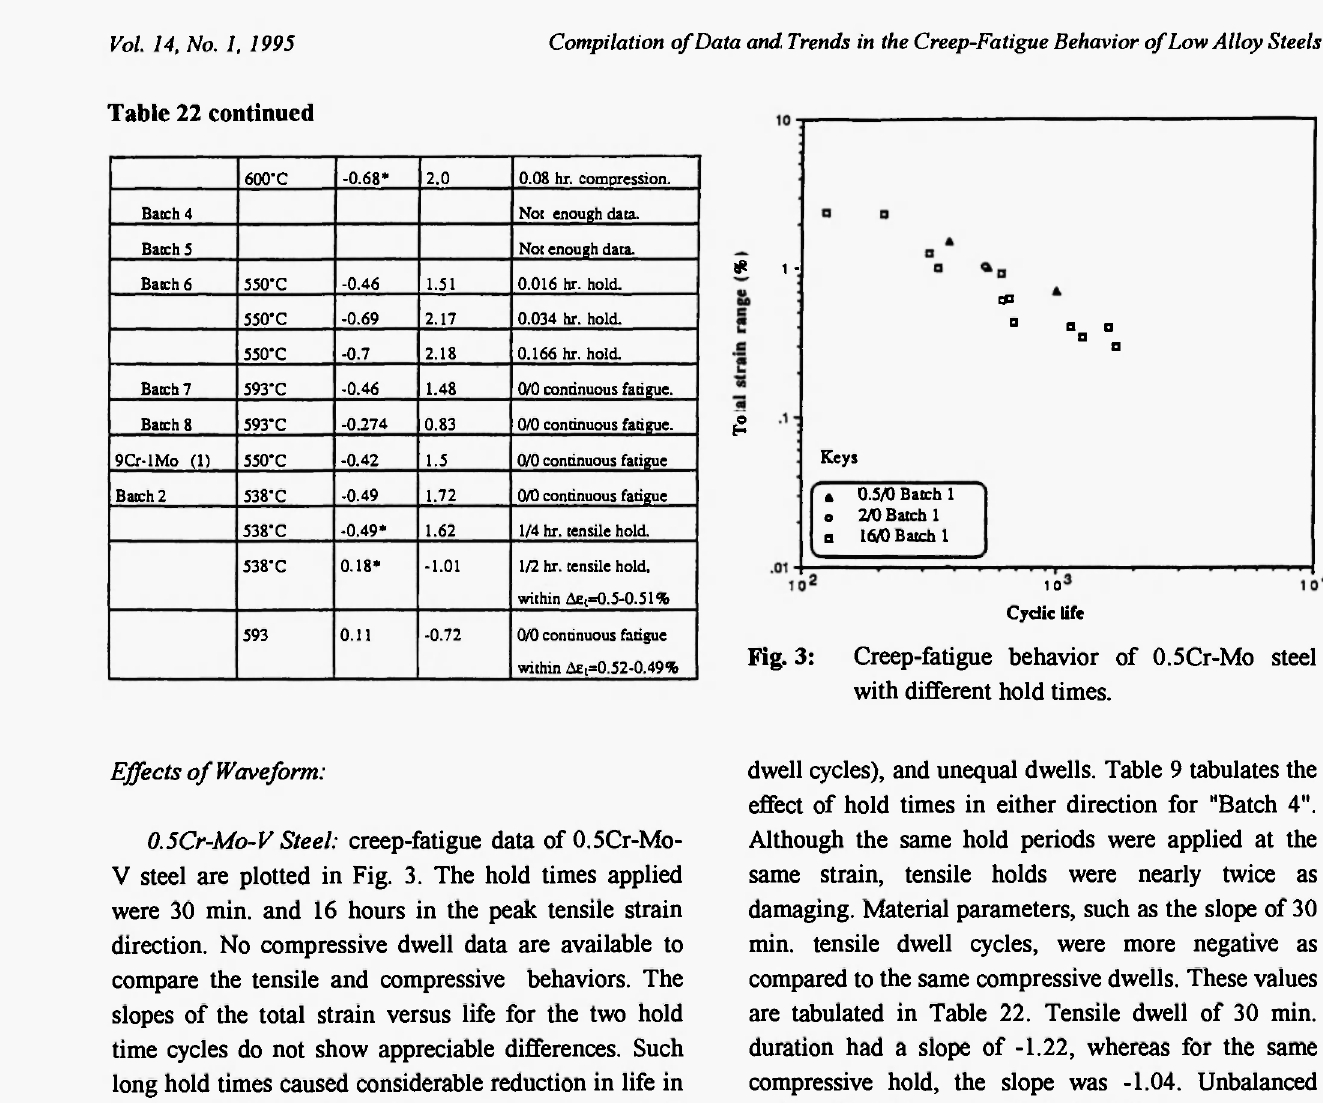
Fig. 4. In the case of creep-fatigue interactions where a dwell effect accumulates, creep damage follows through stress or strain relaxations, which occur under constant strain or stress holds respectively. When the magnitude of the relaxed strains exceeds the creep ductility, failure occurs /19/. Creep-ductility of Batch 4, characterized in a forged form, was determined as approximately 5% /20/, depending upon stress, temperature, and time. Apart from the above factors, creep-ductility also depends on material heat and compositions. Exhaustion of ductility or strain accumulation per cycle for